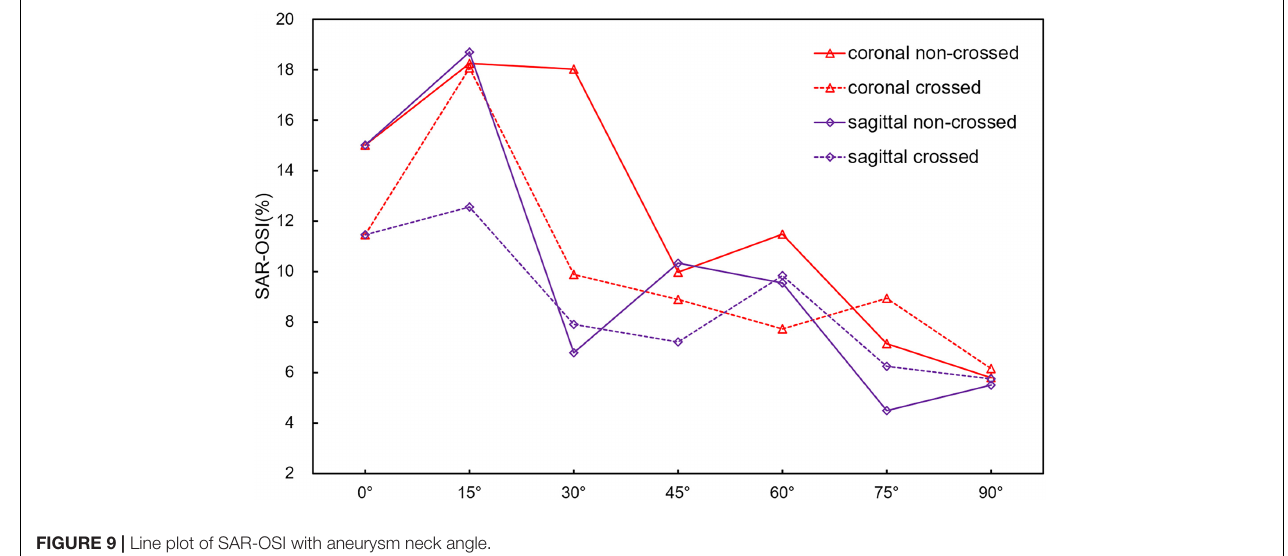
FIGURE 9 | Line plot of SAR-OSI with aneurysm neck angle.